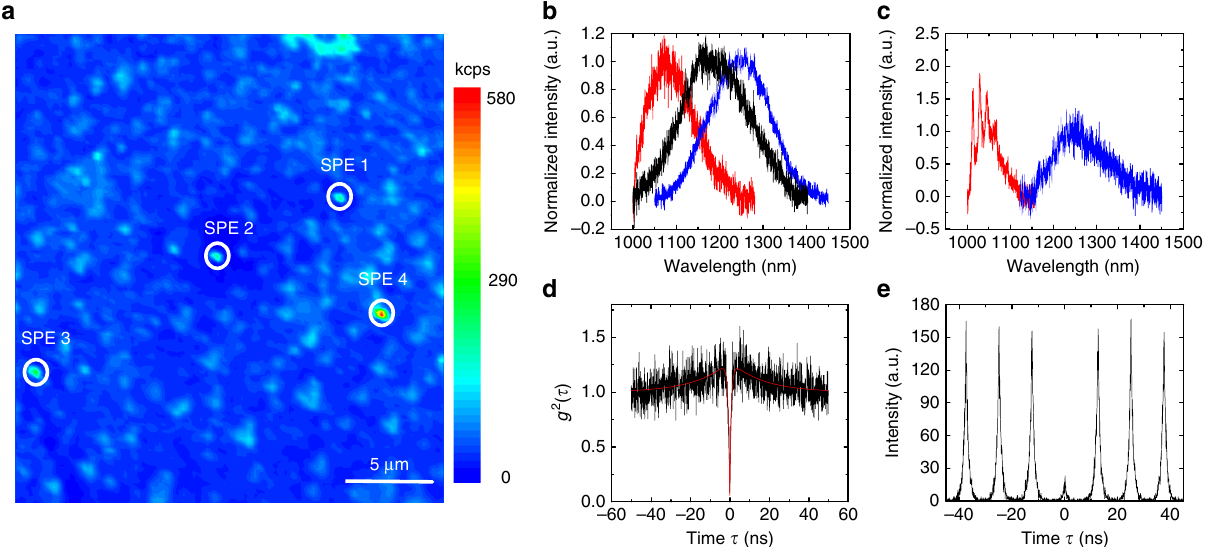
Fig. 1 3C-SiC single-photon emitters. a 25 × 25 µ m 2 confocal can map of the SPEs found in 3C SiC epitaxy layer under 2 mW laser excitation. The scale bar is 5 µ m. SPEs are marked with white circles. b Three representative RT PL spectrums of the SPEs. c Two representative PL spectrums of the SPEs at cryogenic temperature (5 K). d Second-order autocorrelation function of SPE 4 with g 2 (0) = 0.05 ± 0.03 under 0.2 mW continuous wave (CW) laser excitation. The black line is the raw data and red solid line is the fi tting with Eq. (1). e Second-order autocorrelation function of SPE 4 with g 2 (0) = 0.13 ± 0.02 under pulsed laser excitation (50 µ